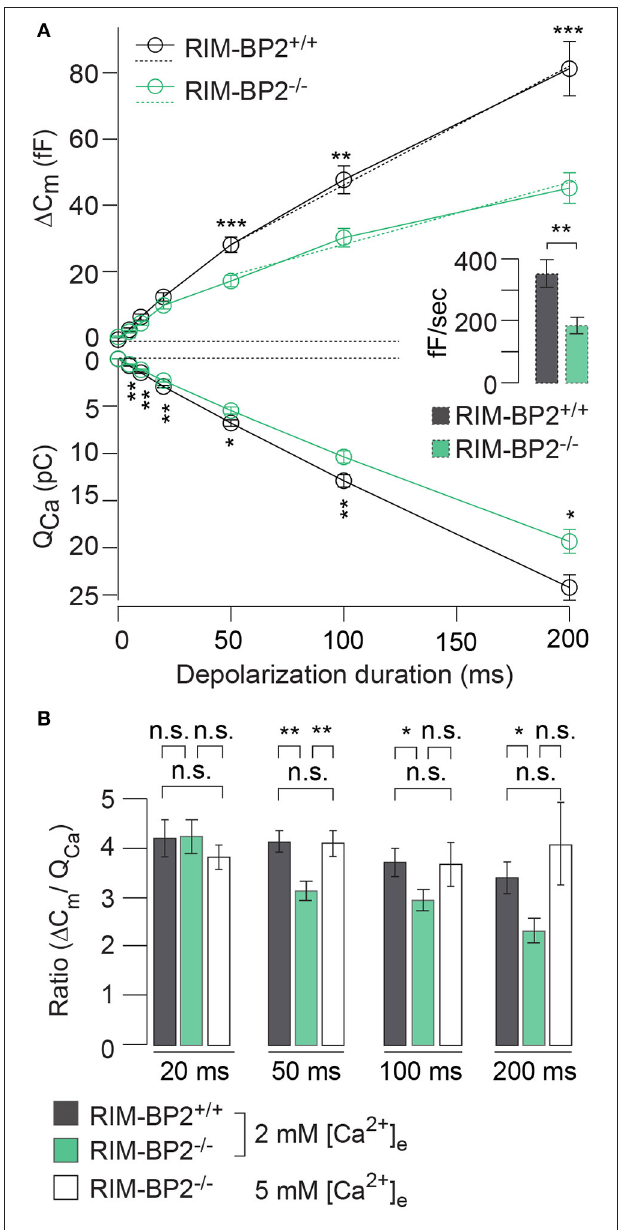
FIGURE 6 | RIM-BP2 promotes sustained exocytosis in IHCs. (A) Left : Relationship of the exocytic membrane capacitance changes ( 1 C m , top) and the corresponding whole-cell Ca 2 + -current integrals (Q Ca , bottom) of RIM-BP2-deficient ( RIM-BP2 − / − , n = 10, green) and control ( RIM-BP2 + / + , n = 12, black) IHCs for various depolarization durations to − 14mV. Ca 2 + -current integrals were significantly reduced during all depolarization durations ( p = 0.01–0.002). Exocytic 1 C m was significantly reduced in RIM-BP2 − / − IHCs during 50 ( p = 0.0007), 100 ( p = 0.002), and 200ms ( p = 0.0007) depolarizations representing the sustained phase of SV release whose rate is governed by vesicle resupply to the RRP. A line was fit to the sustained phase of exocytosis to each individual IHC (from 50 to 200ms, dashed line) to estimate the kinetics of vesicle turnover during ongoing stimulation. Right: IHC grand average (mean ± SEM) of line fit slopes as estimates for SV turnover rates. A significant reduction (Wilcoxon rank test, p = 0.001) was observed in RIM-BP2 − / − IHCs( n = 10,green)comparedtocontrol RIM-BP2 + / + ( n = 12,